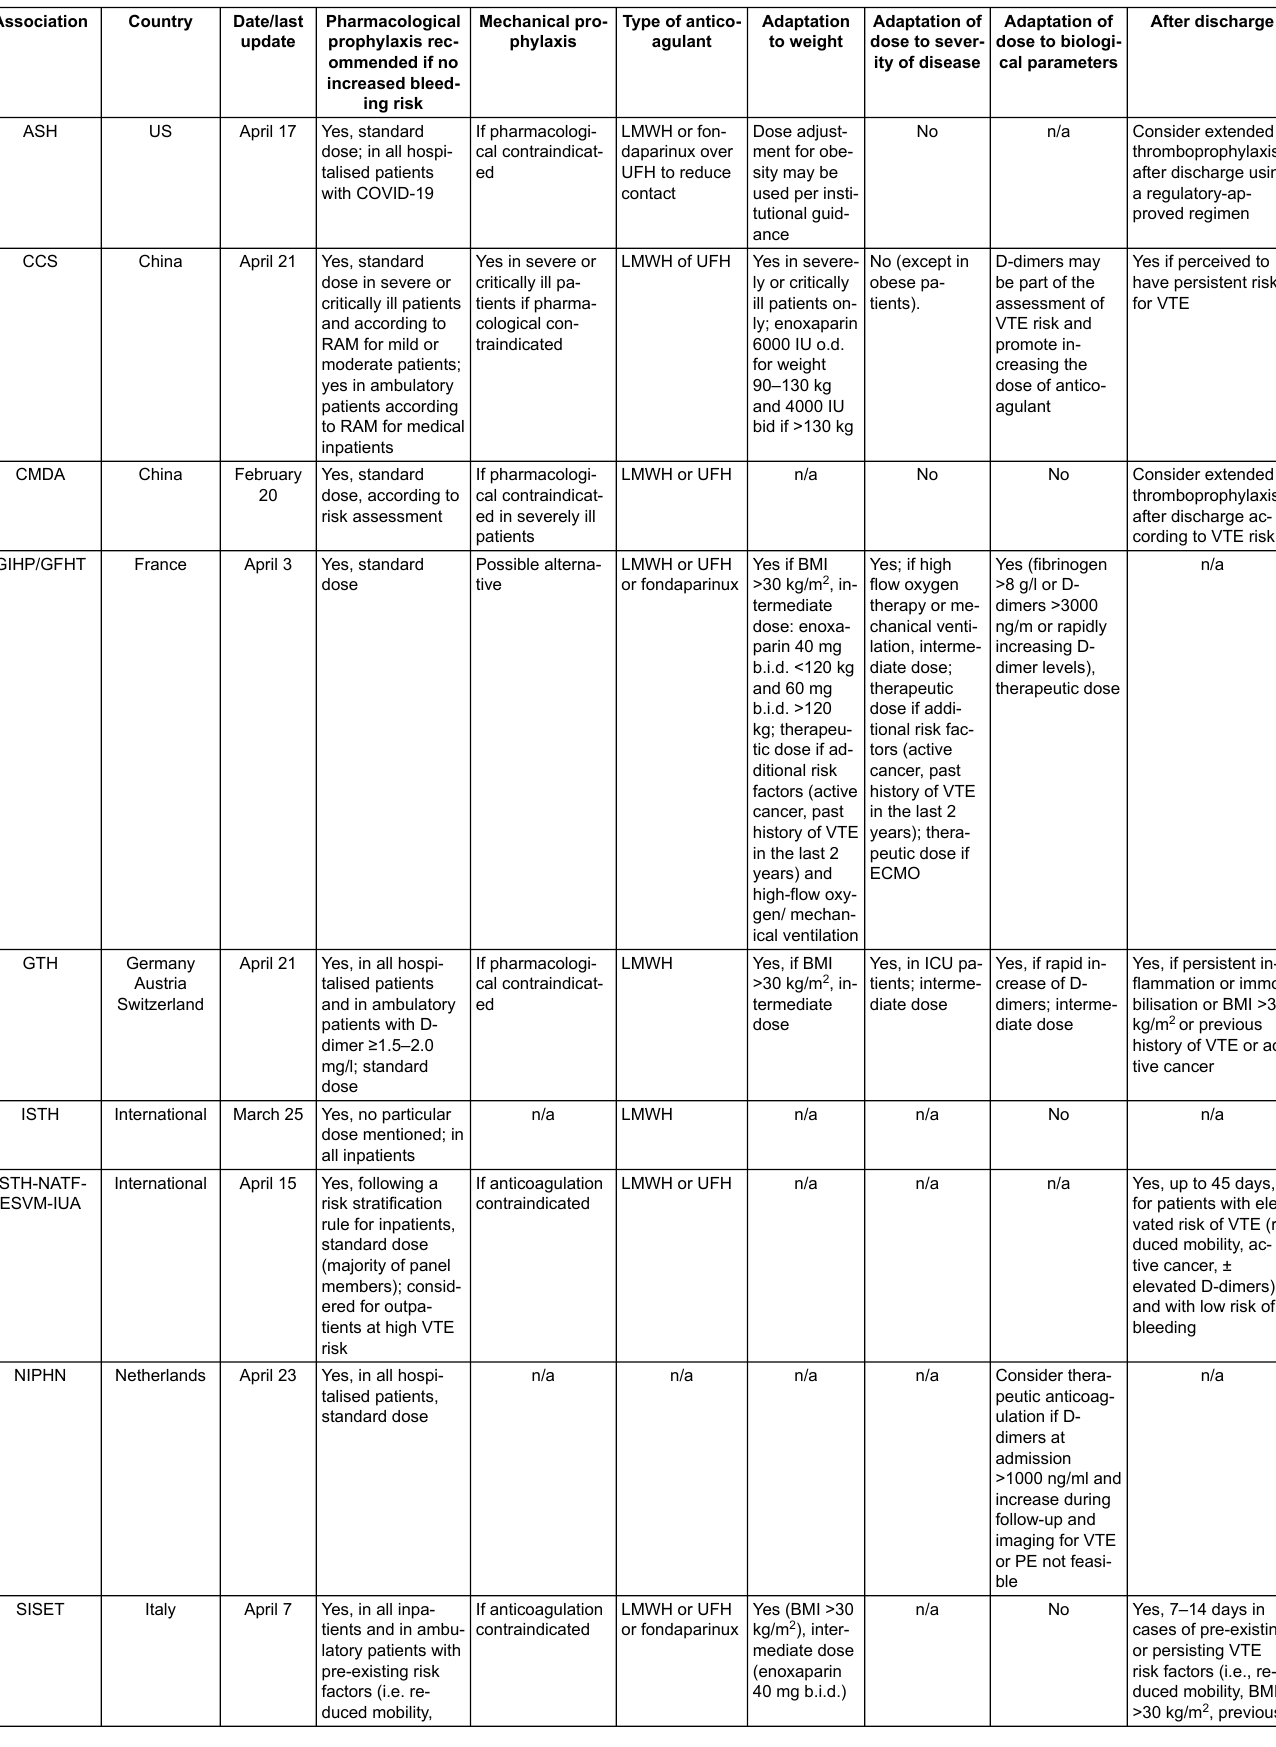
Table 3: Summary of thromboprophylaxis policies for COVID-19